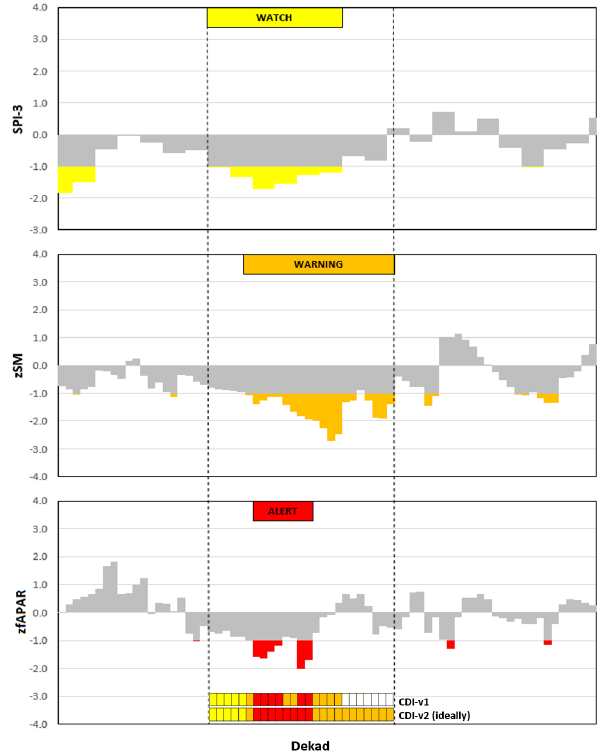
Figure 3. Example of the small gaps that can occur during a drought event in France. Dotted lines delimit the period under drought, whereas the squares at the bottom of the plots report the outcome of the operational CDI (CDI-v1, upper line) and the ideal evolution of a revised version’s (CDI-v2 ideally, lower line) values for each